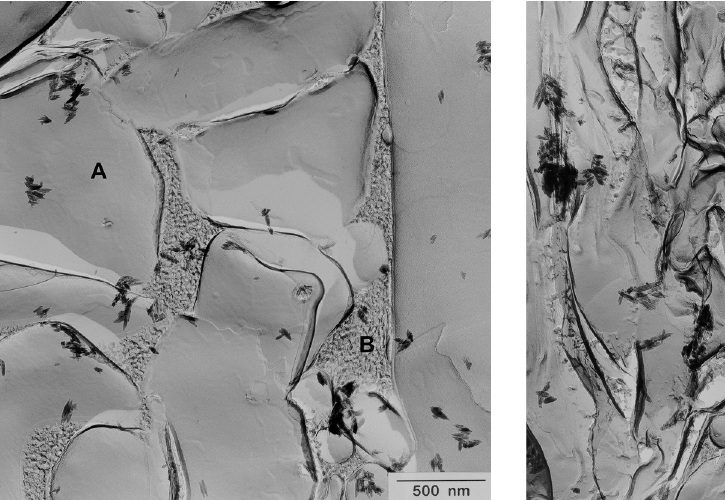
Figure 5 (left): TEM micrograph of o/w emulsion D after one week of storage at room temperature. Figure 6: TEM micrograph of o/w emulsion D after one week of storage at